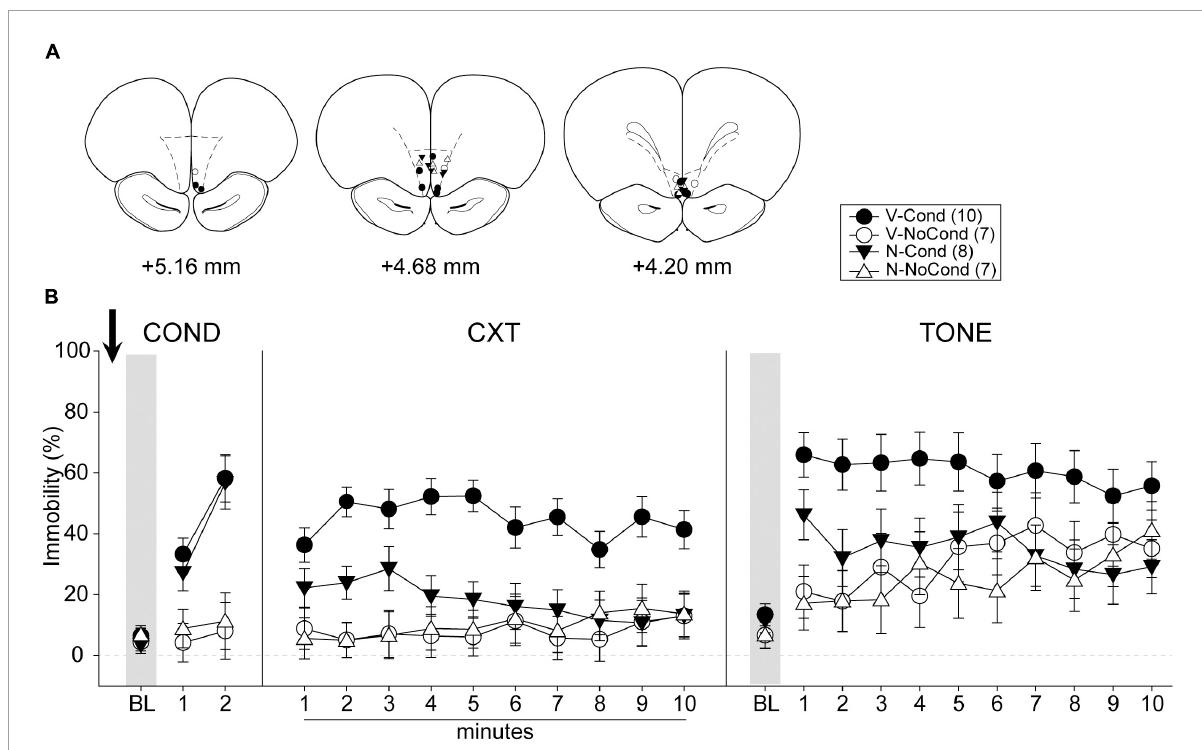
FIGURE5 Medial OFC (mOFC) activation during fear conditioning interfered with the acquisition/consolidation of contextual fear and cued fear. (A) Injection sites in the mOFC for all the animals included in data analyses at levels of +5.16, +4.68, and +4.20 mm, anterior relative to bregma. (B) Percentage of immobility during the conditioning (left panel), contextual test (middle panel), and tone test (right panel). N, N-methyl-D-aspartate (NMDA); V, vehicle; Cond, conditioning; NoCond, no-conditioning. All data shown as the mean ± SEM.